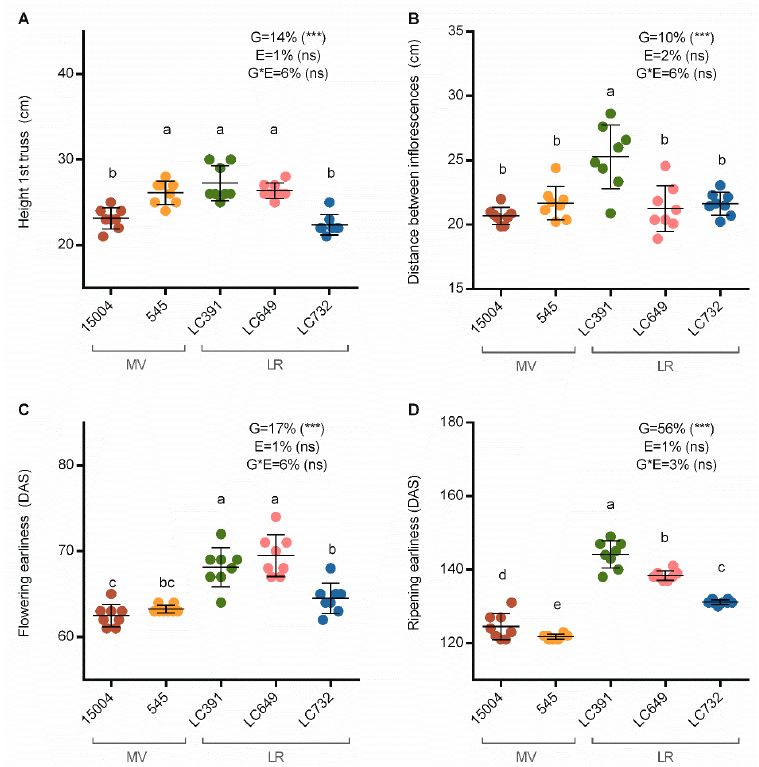
Figure 2. Differences between modern varieties (545, 15004) and landraces (LC391, LC649, LC732) in plant architecture and earliness traits. ( A ) Height of the first truss, ( B ) distance between inflorescences, ( C ) flowering earliness (1st truss), ( D ) ripening earliness (3rd truss). Mean ± SEM calculated from 2017 trials (Exp7–Exp16). Within graphs, different letters indicate significant differences